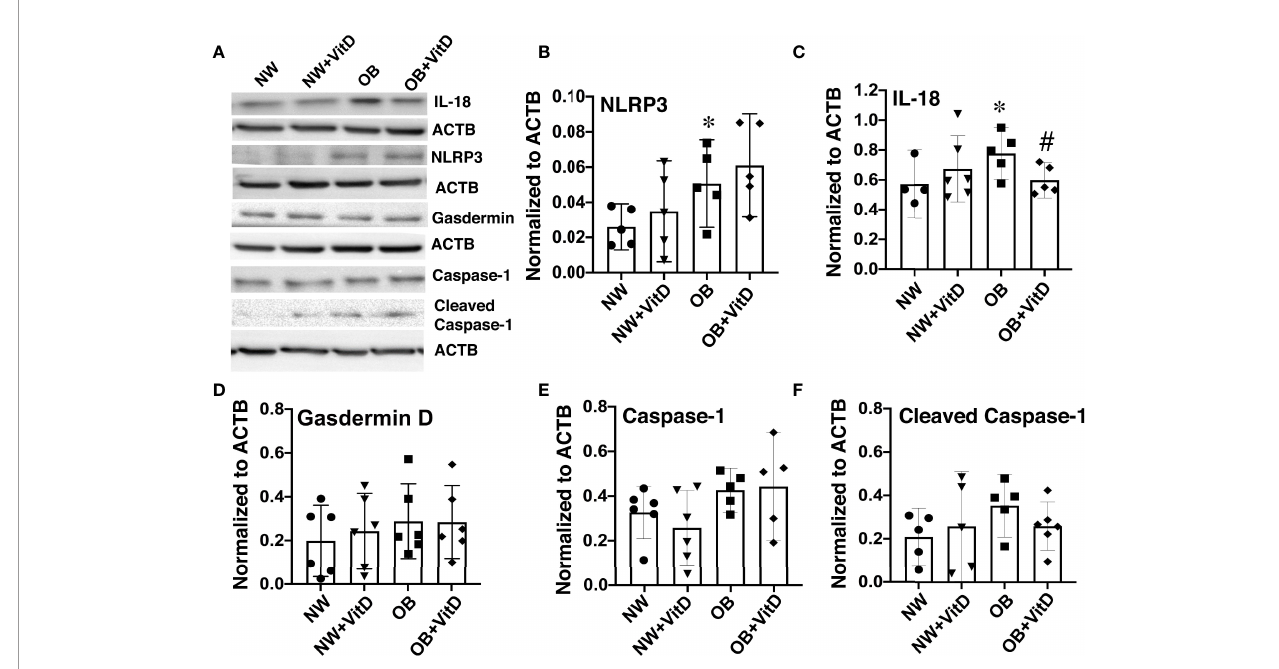
FIGURE 5 | Effect of 24-hour calcitriol treatment on protein expression of NLRP3 in fl ammasome and the downstream in fl ammasome activation and pyroptosis factors IL-18, gasdermin D, and caspase-1 in trophoblasts isolated from placentae of normal-weight and obese women. Data from males and females were combined. (A) Representative Western blots. (B) NLRP3. (C) IL-18. (D) Gasdermin (D, E) Total caspase-1. (F) Cleaved p20 caspase-1. Data were normalized to b -actin (ACTB) and expressed as fold-change relative to untreated cells. *, p < 0.05. N=6-7. #, p<0.05 vitamin D treated vs. untreated